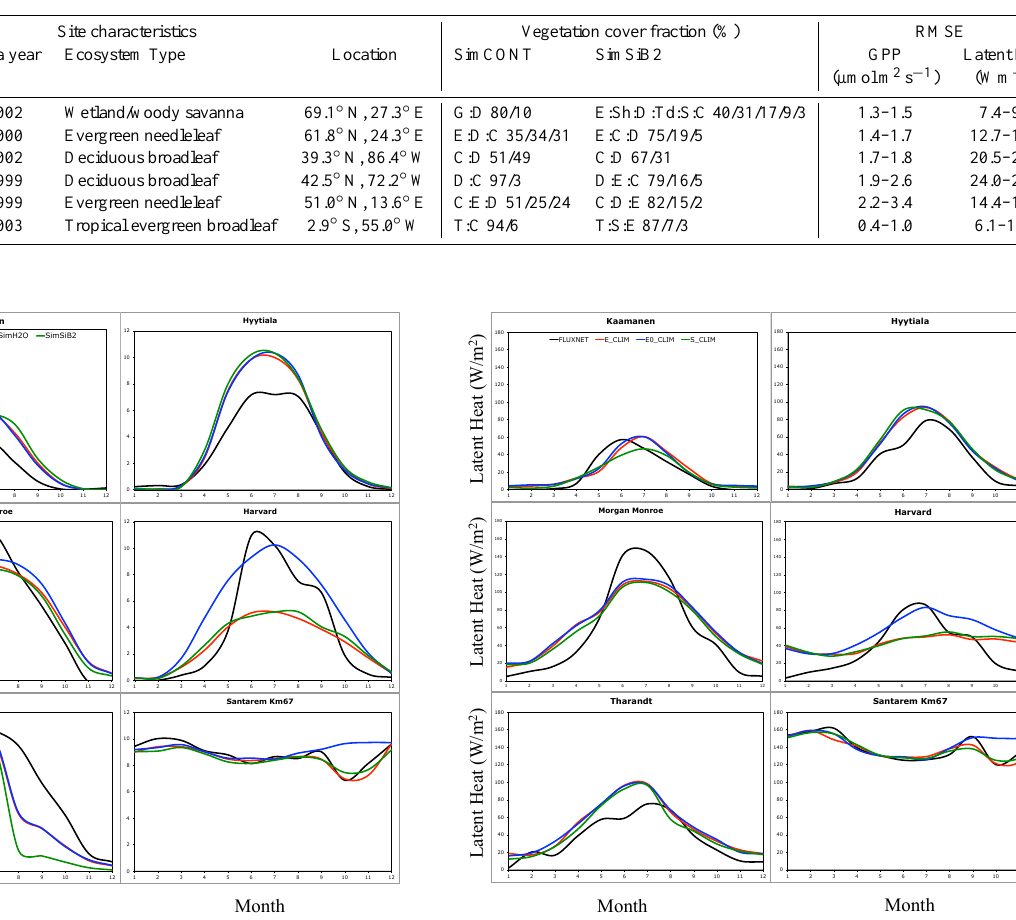
Table 3. Summary of FLUXNET benchmark site characteristics, model vegetation cover fractions for the grid cell in which the site is located and model performance in terms of RMSE range across the model runs. Td=tundra; G=grass; Sh=shrub; S=savanna; D=deciduous; T=tropical rainforest; E=evergreen; and C=crop.